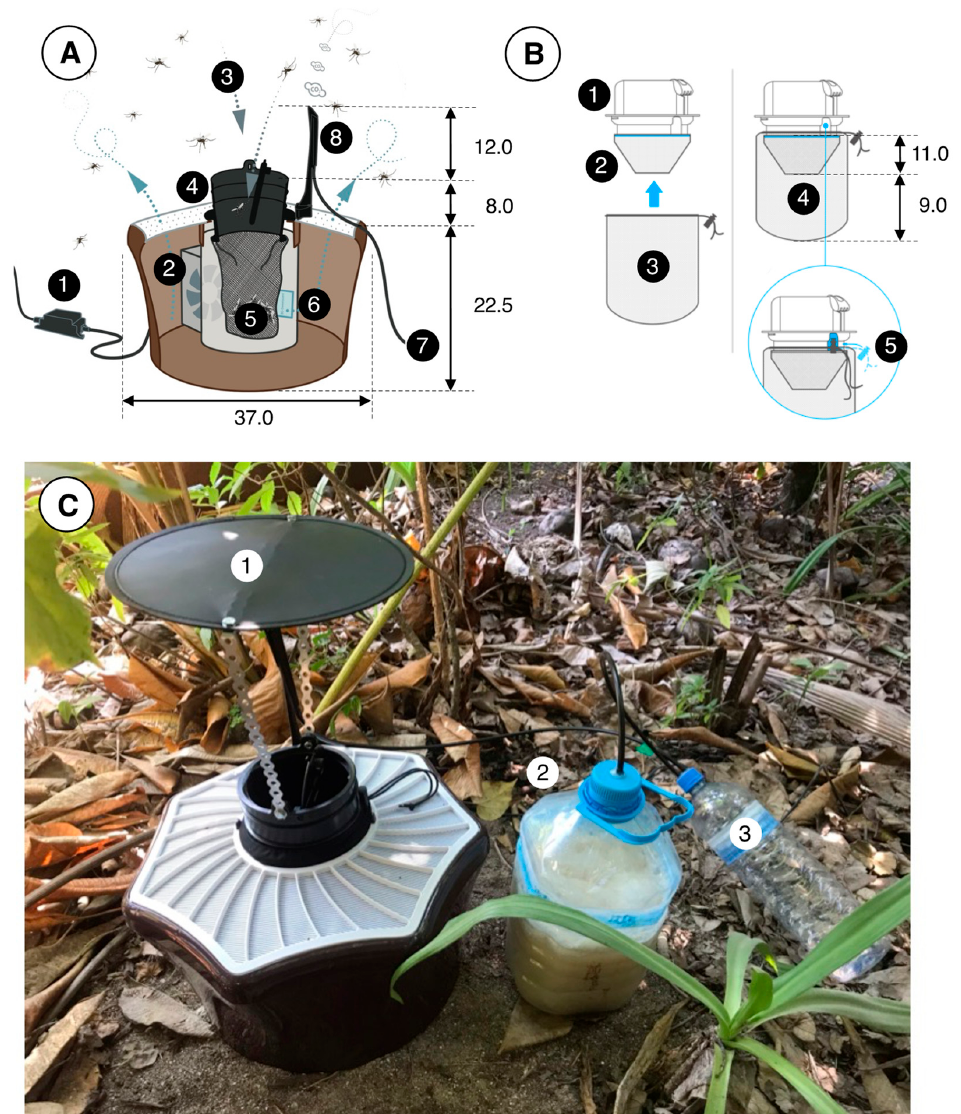
Figure 3. The BG-MosquitaireCO2 trap and its operation. ( A ): An adapter (1) converts power from the mains to 12 V DC (0.3 A, 3.6 W), which provides power to a fan (2) located inside the trap. Suction (ca. 3 m/sec) by the fan creates an inward airflow (3) through the black trap inlet (4) and the catch bag (5, see ( B )) and odor-laden air (with lactic and hexanoic acid emanating from a sachet) (6) leaves the trap via its perforated white top. Carbon dioxide is provided though 6 mm plastic tubing (7) and released from a nozzle at the top of the trap (8). ( B ): The inlet (1) of the trap has two netting bags attached to it, a so-called funnel bag (2), which prevents mosquitoes from flying upwards, and the catch bag (3). Both bags (4) are fitted on the inlet (5) using an elastic string. ( C ): A trap in the field, fitted with a roof (1) to prevent rain from entering the trap. The 5 L water bottle (2) that contains 3 L of water, 700 g of sugar and 20–40 g of yeast to produce CO 2 is located next to the trap. A 1.5 L overflow bottle (3) prevents liquid/foam from this mixture from entering the tubes and nozzle, which might otherwise become clogged and disrupt the flow of CO 2 . Tubes were fitted to the polyethylene bottle tops using hot glue. All dimensions are in cm. Image source: ( A , B ) Biogents AG, Germany; ( C ) B.G.J.K.